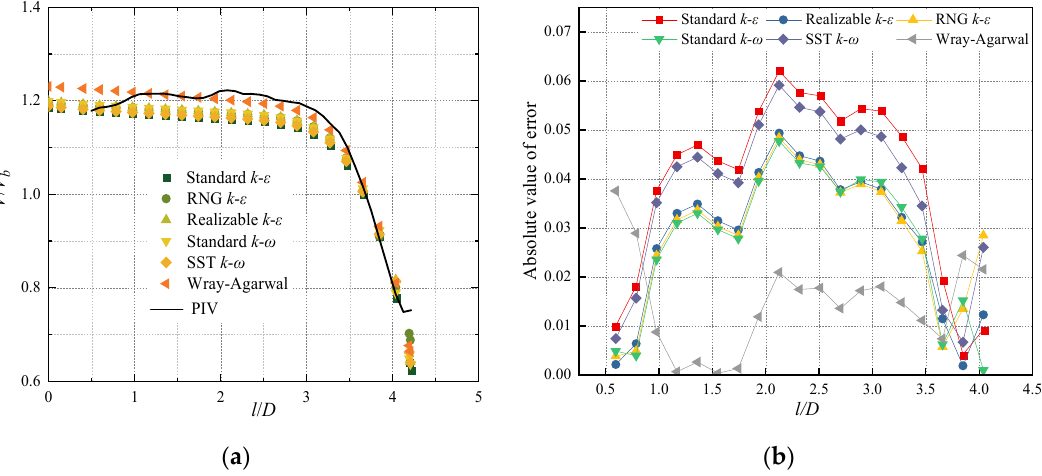
Figure 5. Results and analysis of V / V b obtained from different turbulence models: ( a ) Distribution of axial velocity V / V b along the axis of the jet; ( b ) Absolute error values of numerical results and PIV experiments.